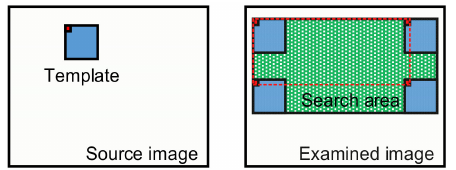
Figure 8. Schematic diagram of the template